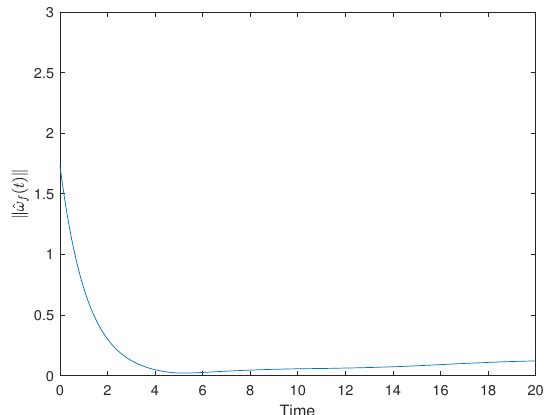
Figure 3. The boundedness of the adaptive NN weight (cid:107) ˆ ω f (cid:107) .